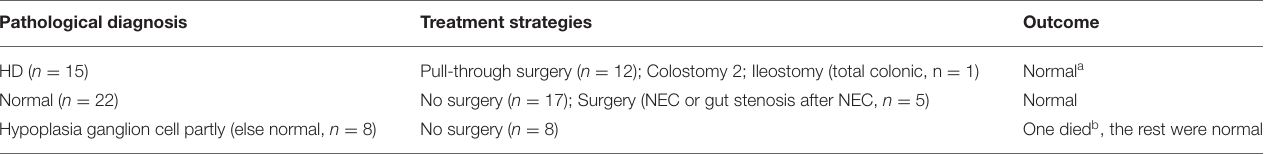
TABLE 2 | Pathological features, treatment strategies, and prognosis of the patients. Pathological